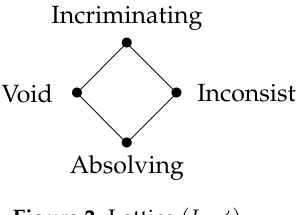
Figure 2. Lattice ( L , (cid:22) )